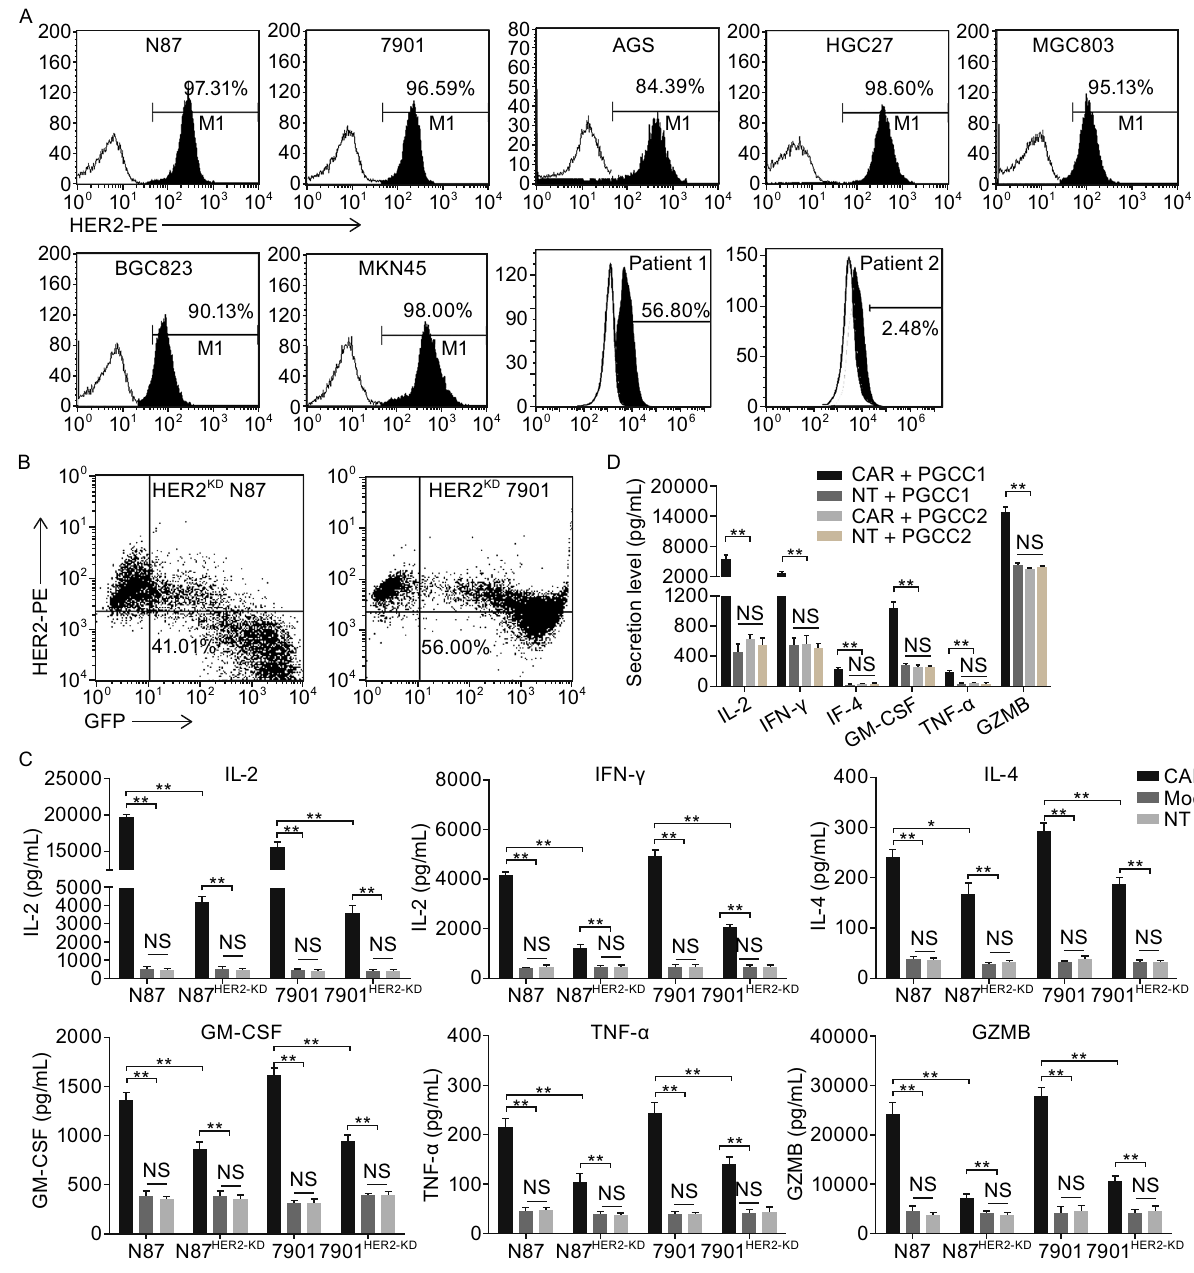
Figure 2. Speci fi c activity of HER2-directed chimeric antigen receptor T cells against HER2 + GC cells. (A) FACS was used to test the surface expression of HER2 proteins in a series of human GC cell lines, including N87, 7901, AGS, HGC27, MGC803, BGC823, MKN45, and primary GC cells from two patients with GC. (B) HER2 expression in N87 and 7901 cells was downregulated via transduction of lentivirus-mediated short hairpin RNA-HER2. The knockdown effects of HER2 expression in sorted GFP-positive cells were evaluated by FACS analysis. (C) The levels of cytokines, released by CART-HER2, mock T, and NT T cells, were measured by enzyme-linked immunosorbent assay (ELISA) after 4-h incubation with HER2 high+ and HER2 KD GC cells at an effector- to-target (E/T) ratio of 20:1. (D) The levels of cytokines, released by CART-HER2 and NT Tcells, were measured by ELISA after 4-h incubation with patient-derived GC cells at an E/T ratio of 20:1. The data are represented as the mean cytokine concentrations ± SD (pg/mL) from triplicate cultures. NS represents no statistical signi fi cance, *represents P < 0.05, **represents P <